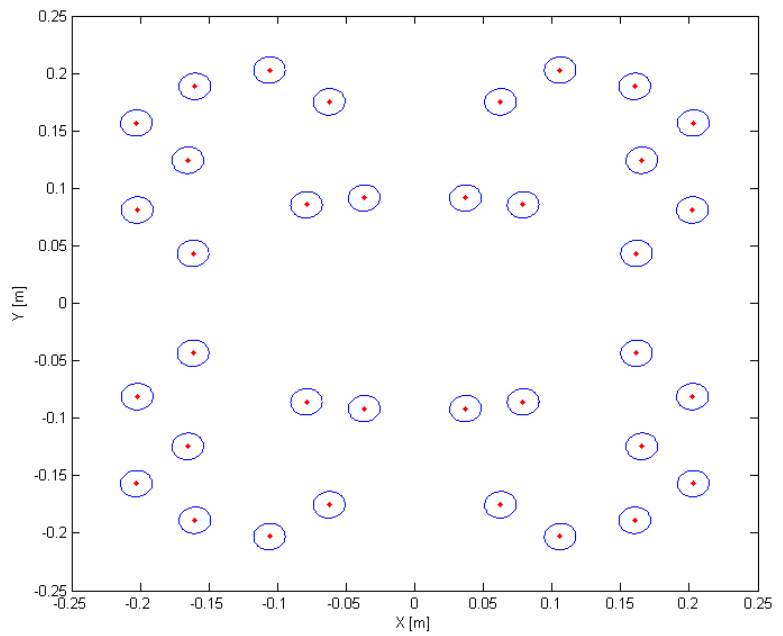
Figure 11. Optimal LED positions calculated with the multiple objective genetics algorithm for a number of 36 LEDs. The search space was reduced to a plane at 60 cm from the target plane and all LEDs are oriented parallel with this plane.